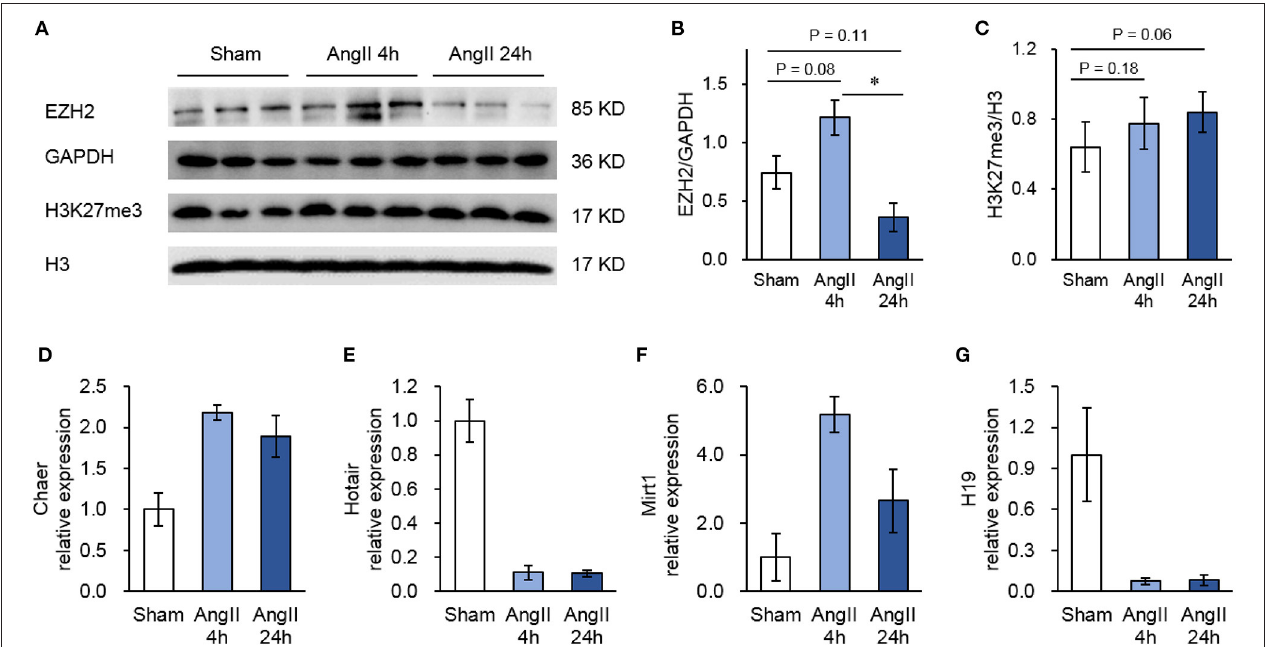
FIGURE 1 | Validation of the RIP method to pull-down Ezh2-binding lncRNAs. (A) Representative immunoblots showing the expression of EZH2, GAPDH, H3K27me3, and H3 in mouse hearts treated with Angiotensin II (AngII) at 0 (Sham), 4 and 24h. (B,C) Analyzed results of EZH2 expression in relative to GAPDH (B) and H3K27me3 expression in relative to H3 (C) . Data are mean ± SEM; * P < 0.05 vs. sham; n = 3. (D–G) Relative expression of known EZH2-binding lncRNAs including Chaer (D) , Hotair (E) , Mirt1 (F), and H19 (G) in mouse hearts treated with Angiotensin II (AngII) at 0 (Sham), 4 and 24h. Data are mean ± SD from two independent